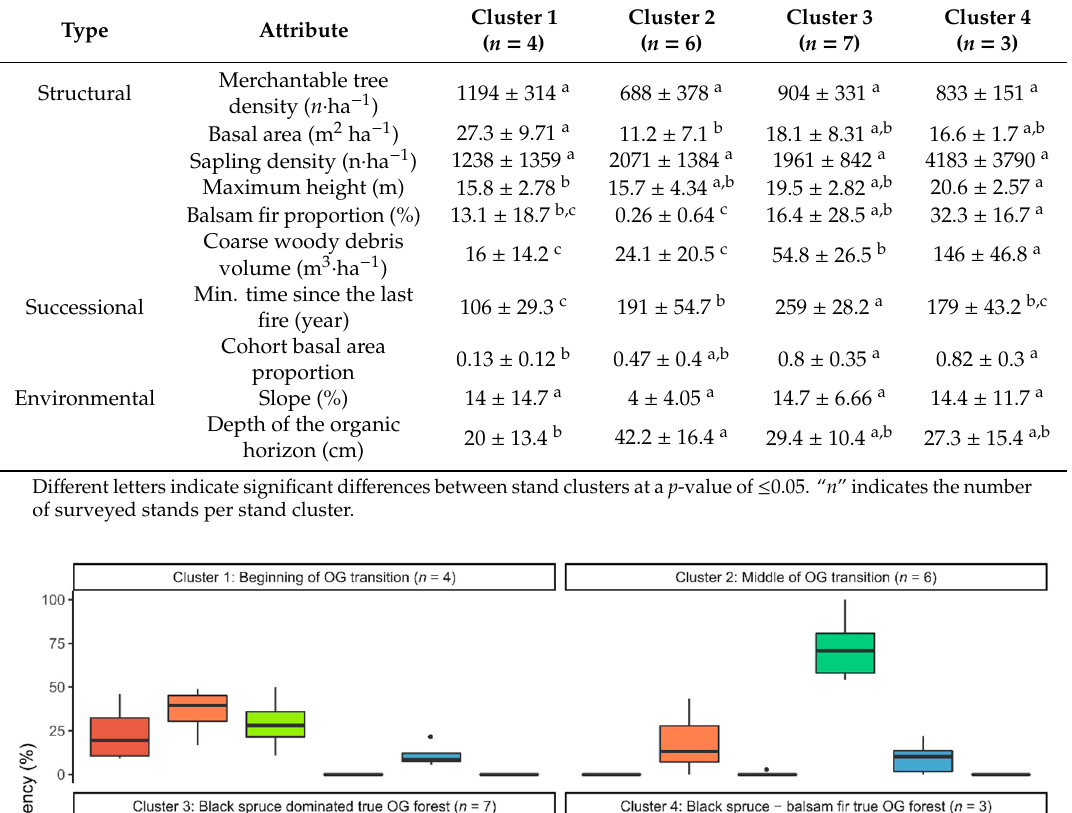
Table 3. Mean and standard error of the structural, successional, and environmental attributes for each cluster.